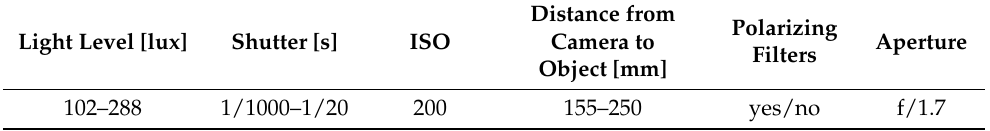
Table 1. Camera and setup